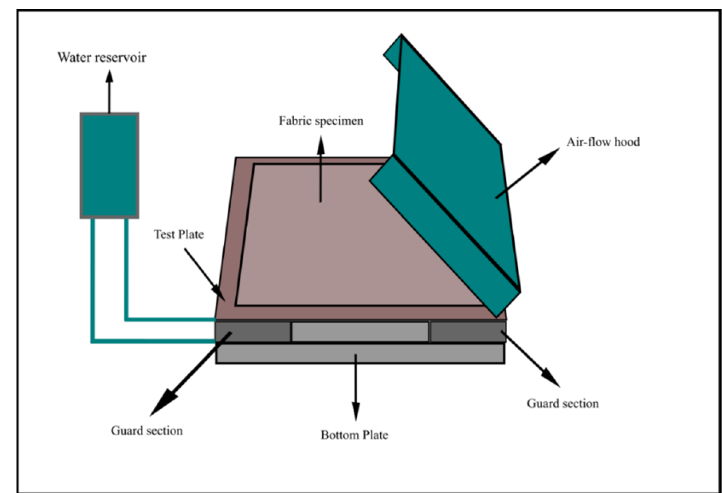
Figure 3. Thermo-physiological comfort performance tester.